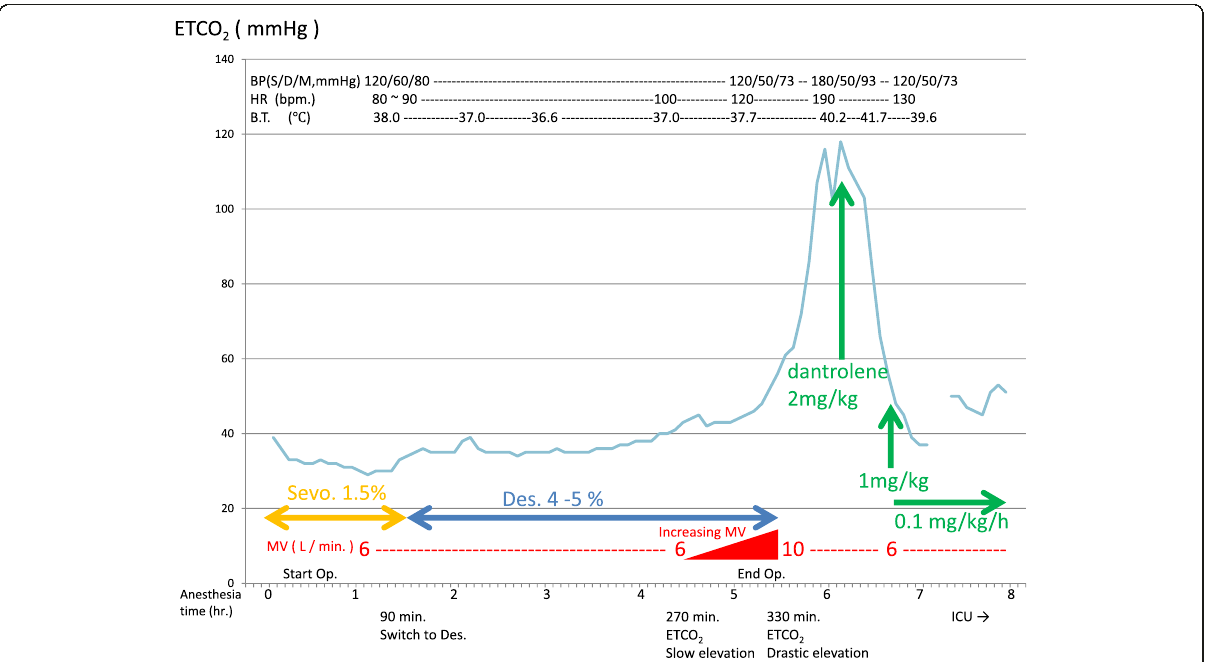
Fig. 1 The anesthesia record of ETCO 2 , blood pressure, heart rate and bladder temperature. Slow elevation of ETCO 2 was observed from 270 min. to 330 min. of anesthesia time, despite of increasing MV up to 10 L / min. 2 mg /kg I.V. dantrolene had a complete response for 111 mmHg uncontrollable ETCO 2 , turning the ETCO 2 down to 60 mmHg after 25 min. One hundred ninety bpm tachycardia, and 180/50 mmHg blood pressure were observed with 41.7 °C peak bladder